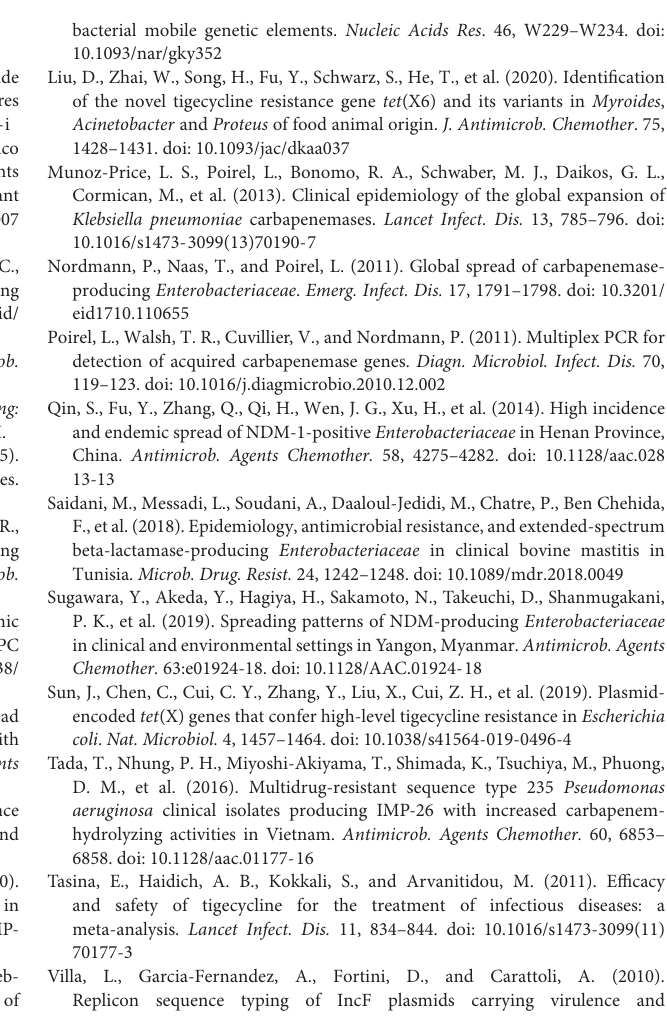
FIGURE S1 | Detection of bla IMP26 − and tet (A) variant- co-carrying plasmid by S1-PFGE and Southern